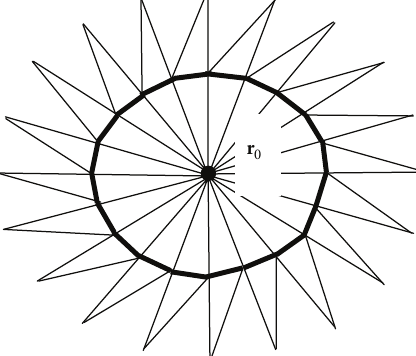
Figure 4: Irregularly-defined flower basis